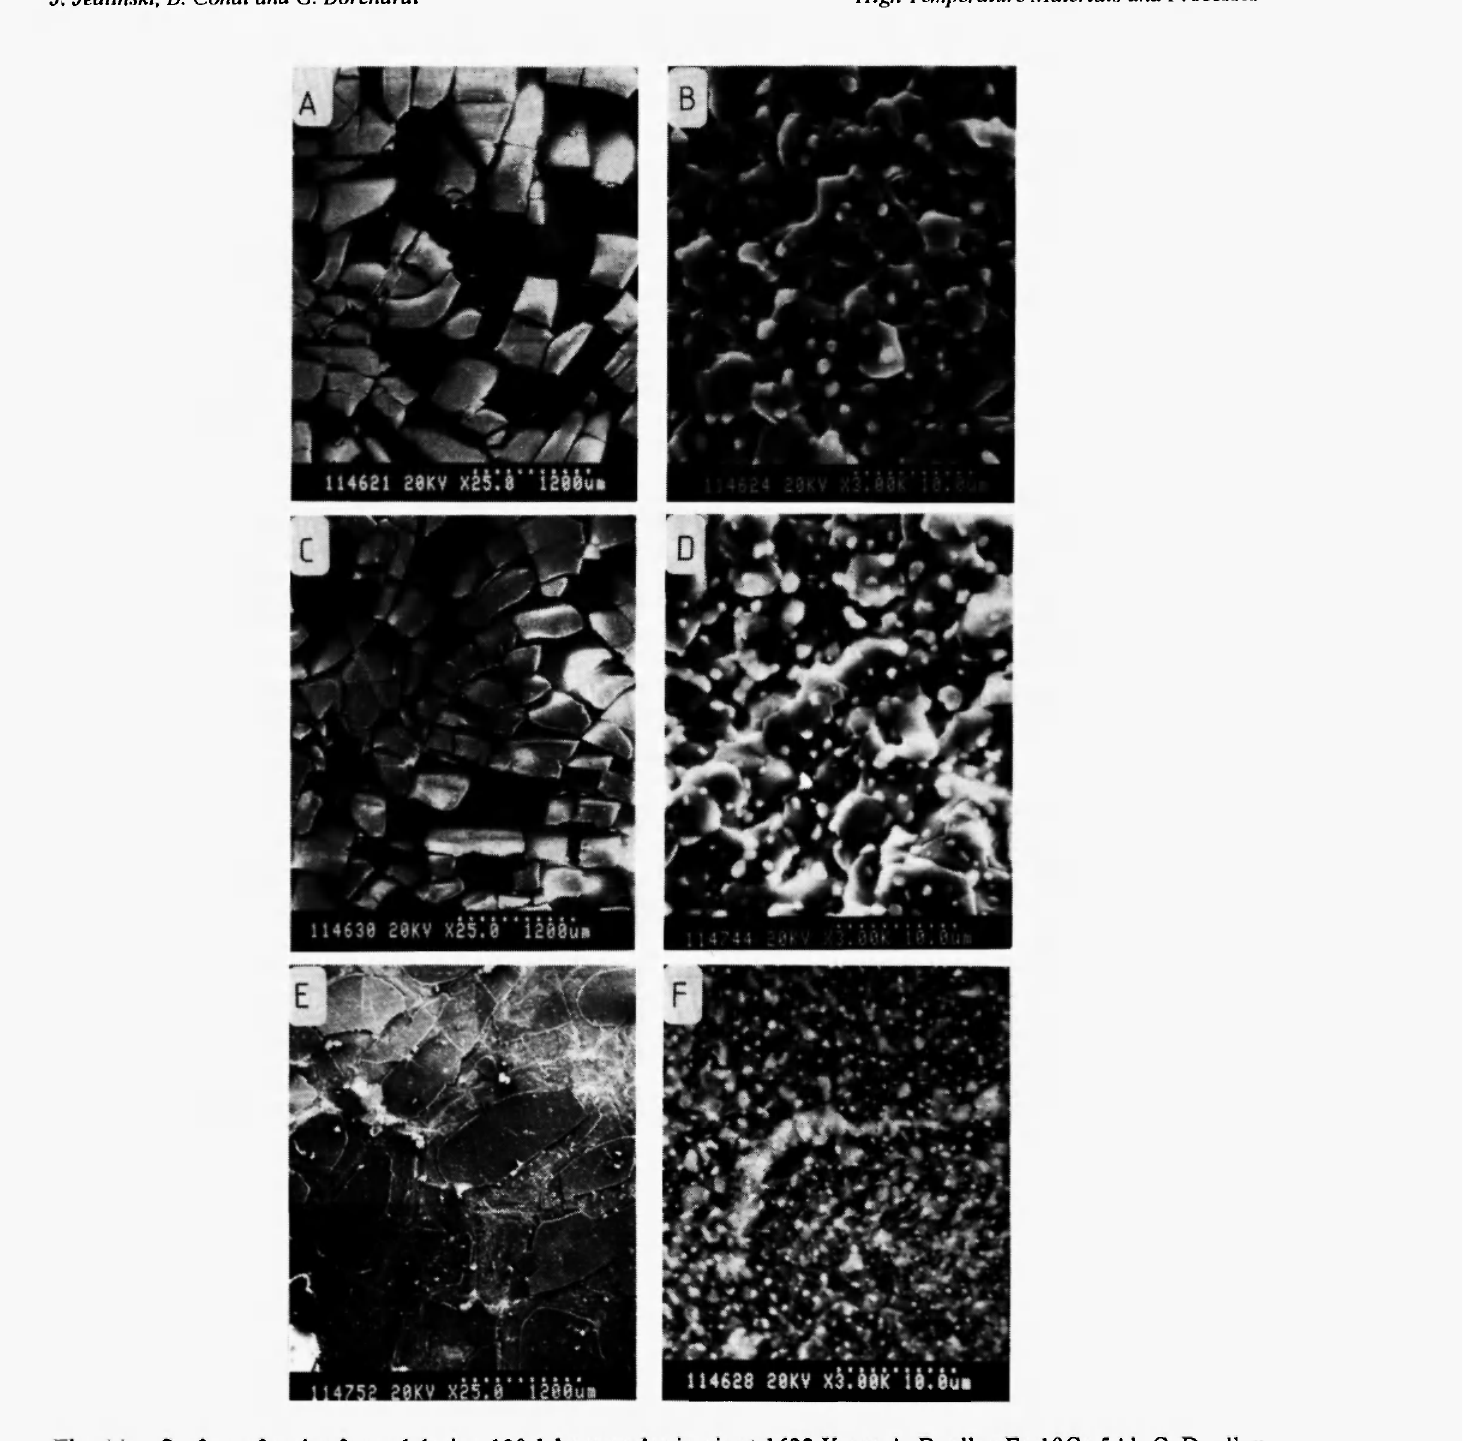
Fig. 14: Surface of scales formed during 130 1-hour cycles in air at 1623 Κ on: A, B. alloy Fe-19Cr-5Al. C. D. alloy Fe-19Cr-5Al implanted with yttrium (2x1010 Y +/cm 2 ), E, F. alloy